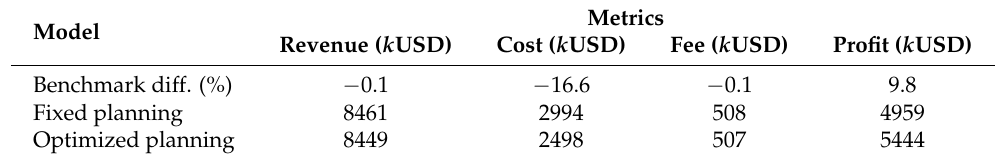
Table 6. DSS versus fixed plan general results.